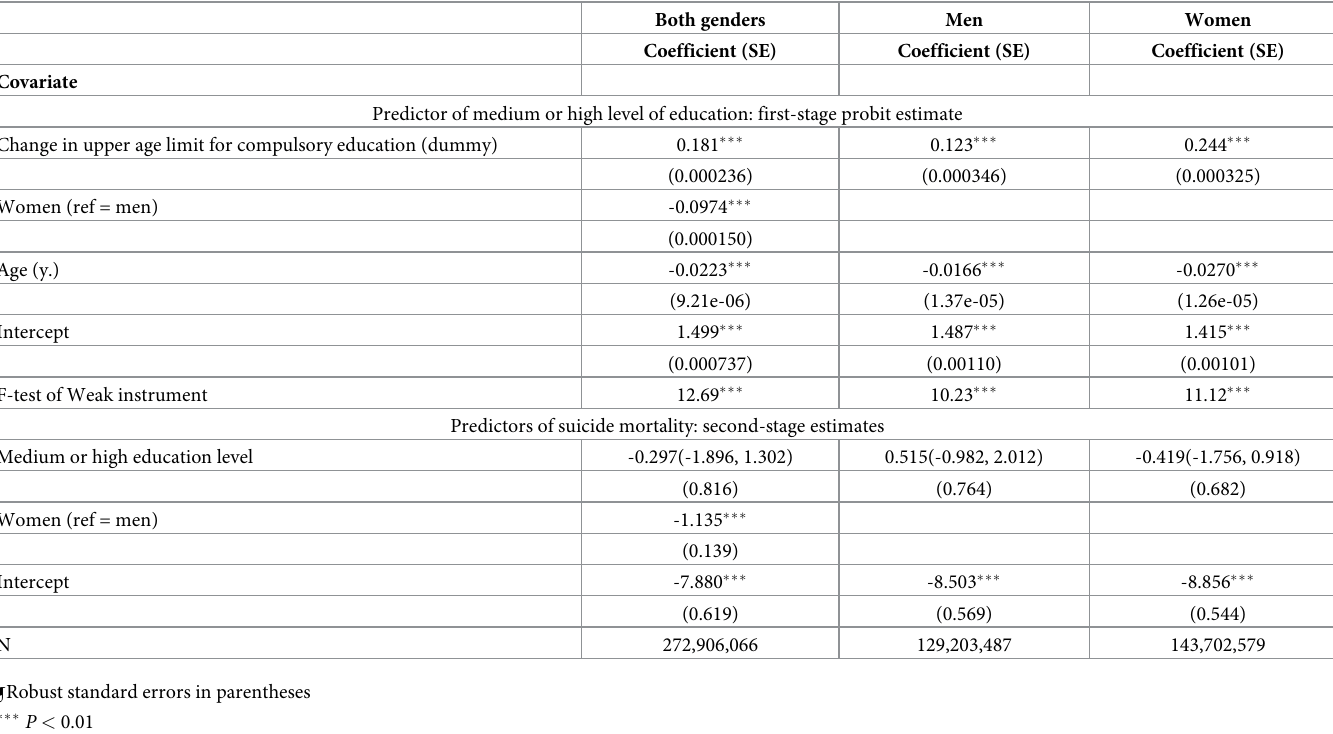
Table 2. Two-stage least square estimates, DEMETRIQ study of twelve European populations,